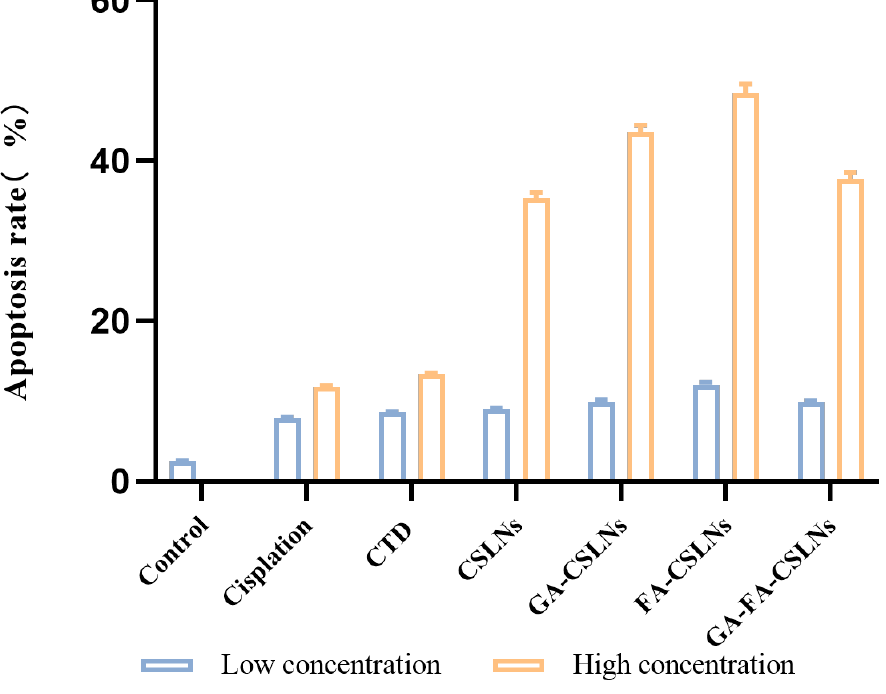
Figure 8. Apoptosis rate of HepG2 cells (mean ± SD, n = 3).